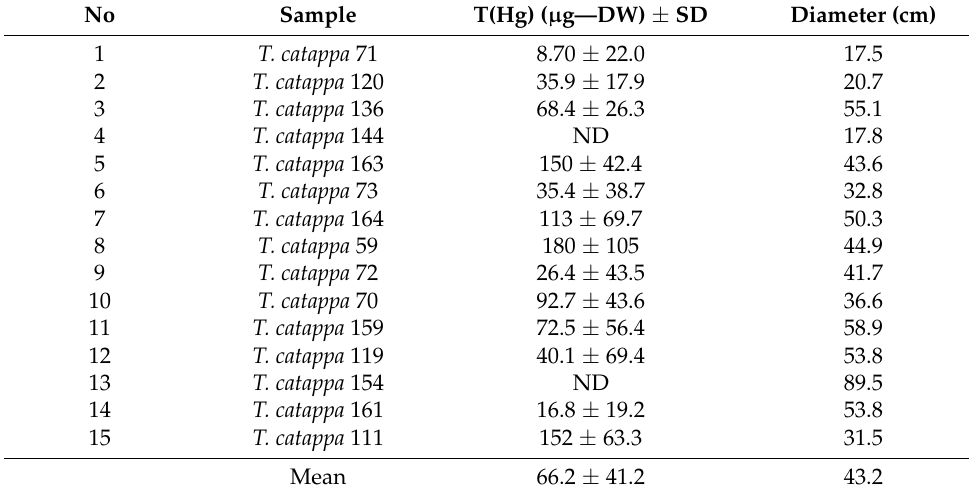
Table 3. Total weight of Hg (THg) in the bark and diameter of Terminalia catappa .